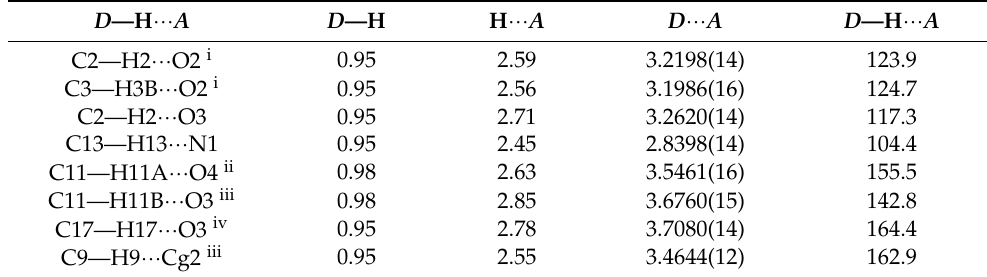
Table 2. Hydrogen-bond geometry (Å, ◦